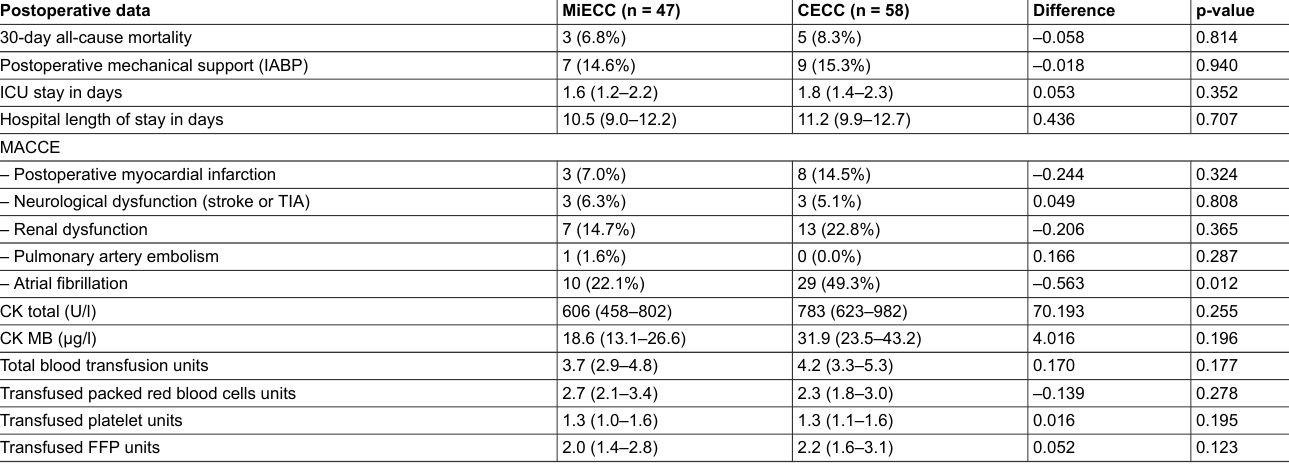
Table 3: Postoperative data after propensity score matching and after inverse probability of treatment weighting (IPTW). Postoperative